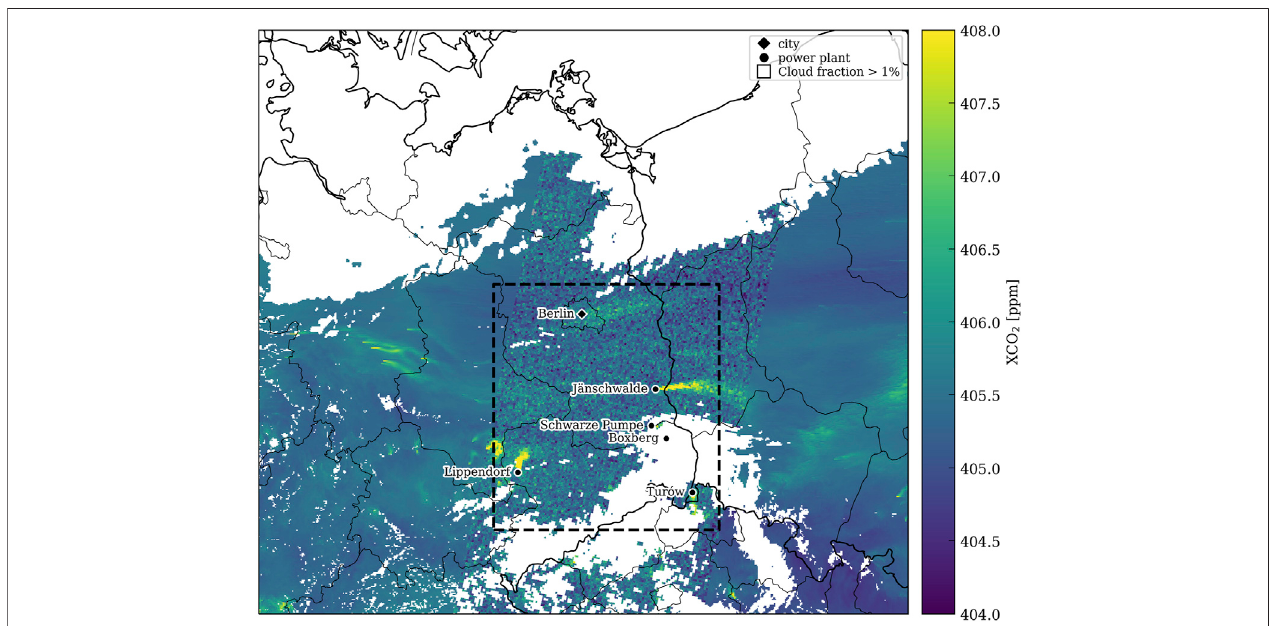
FIGURE 1 | Synthetic XCO 2 observations on 23 April 2015 over a 250 km wide swath of the planned CO2M instrument (low-noise scenario). Simulated SMARTCARB XCO 2 fi eld is illustrated on the background. Missing CO 2 measurements (cloud fraction larger than 1%) are shown in white. The black rectangle indicates the study area. The emission sources considered in the analysis (Berlin, Boxberg, Jänschwalde, Lippendorf, Schwarze Pumpe, and Turów) are highlighted.